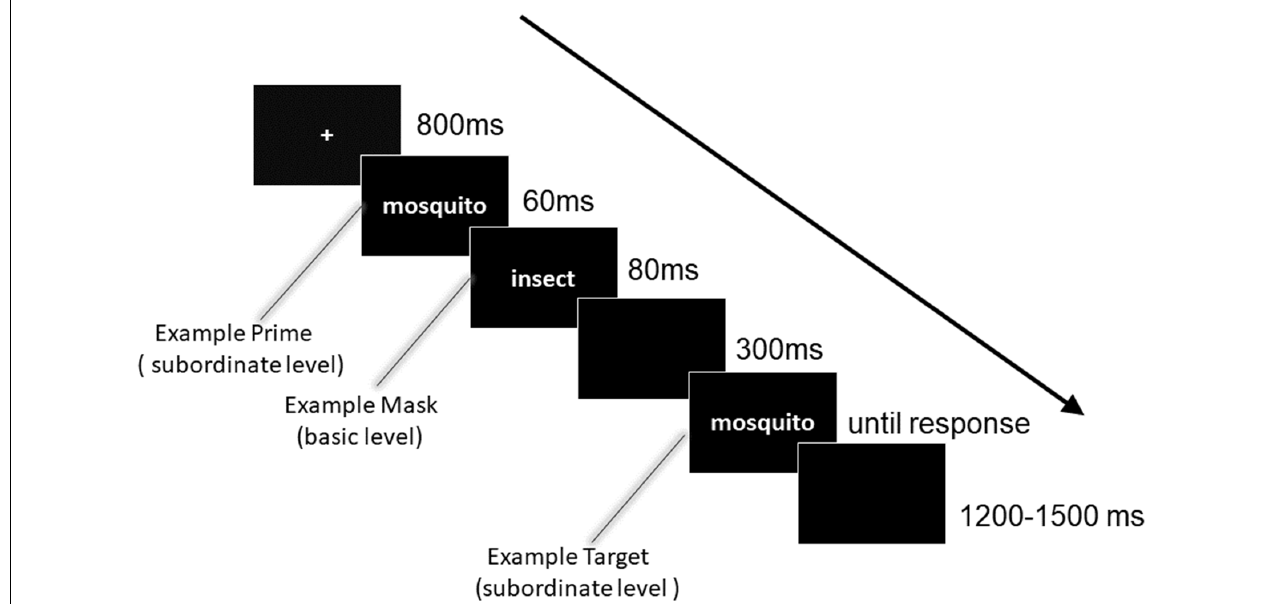
FIGURE 1 | Experimental procedure of the masked priming paradigm. In the present design, four experimental conditions were included, i.e., subordinate- subordinate-subordinate, subordinate-basic-subordinate, subordinate-superordinate-subordinate, and control conditions. To avoid a fixed positive response tendency, priming and target stimuli were either identical or different. Participants were asked to judge whether the priming and target stimuli were identical or not by pressing “F” or “J” key on a standard QWERTY keyboard, or they could press the space bar if could not decide. The number of identical and different trials was the same. Note that the illustration depicts a subordinate masked by basic categorization. Moreover, “mosquito” was a typical representation of “insect.”